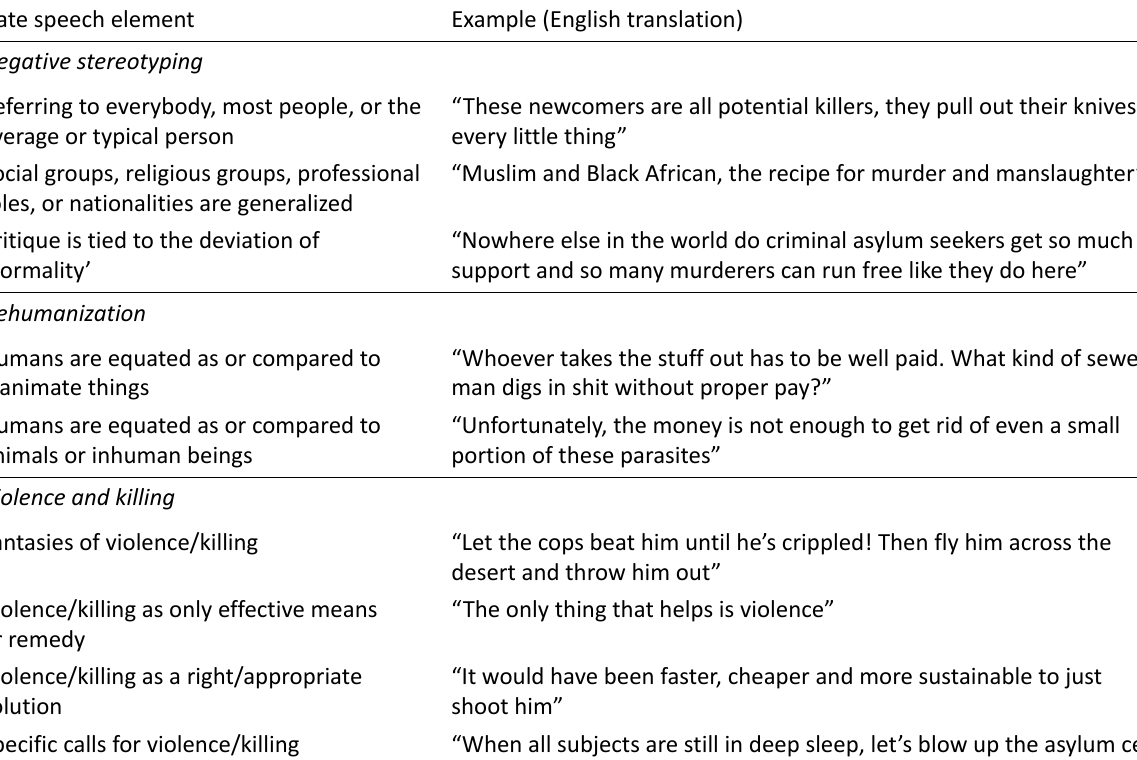
Table 1. Description of hate speech